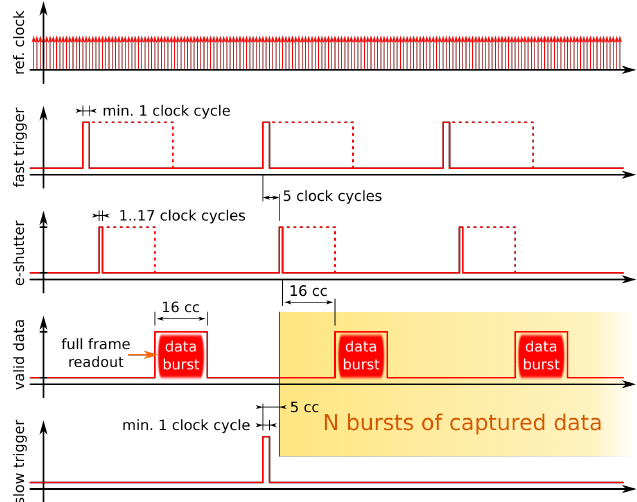
Figure 6. An illustration of the HOLD triggering